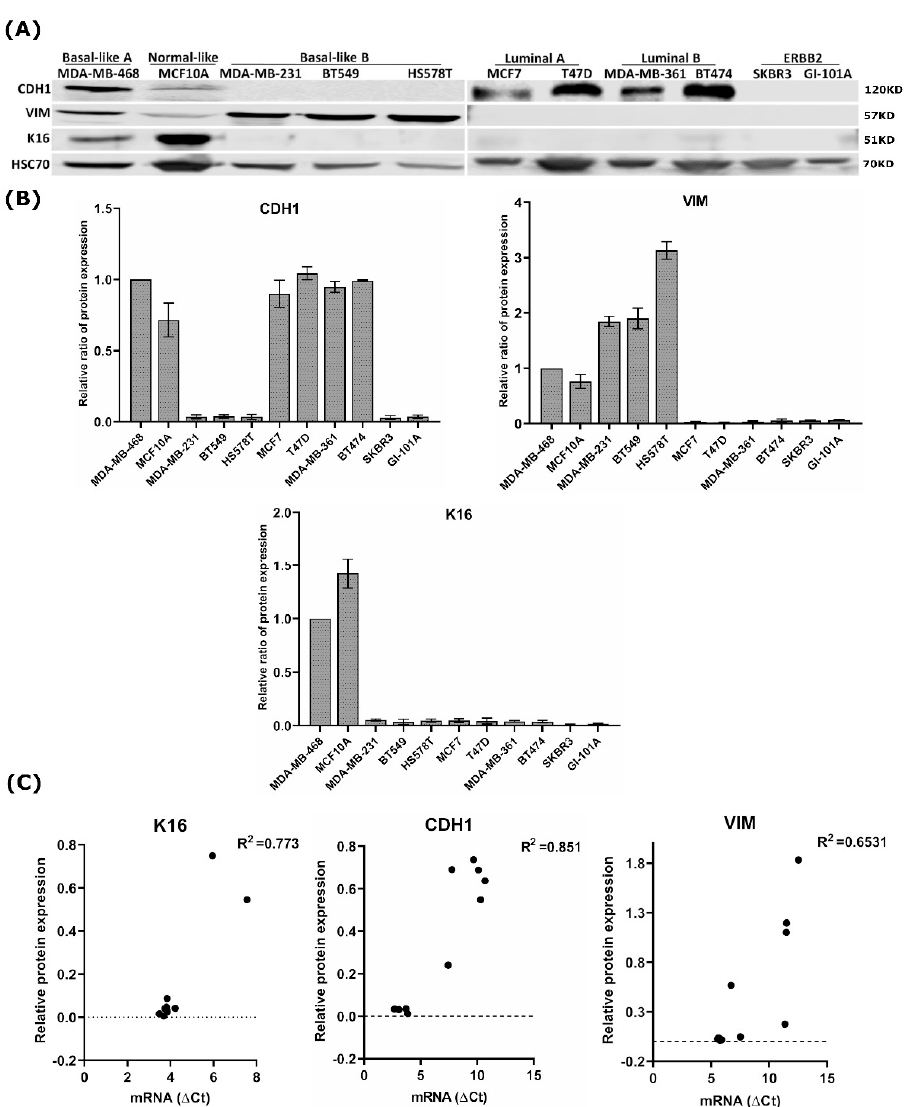
Figure 1. Analysis of the K16 expression in breast cancer cell lines. ( A ) Expression of K16, adherent junction protein CDH1, and mesenchymal intermediate filament VIM in a panel of human breast cancer cell lines using western blot. ( B ) The relative ratio of protein expression of K16, VIM, and CDH1; all quantified values are normalized to the expression level of HSC70 protein and then to MDA-MB-468 as a control ( C ) Correlation between mRNA and protein expression levels of K16, CDH1, and VIM in breast cancer cell lines.